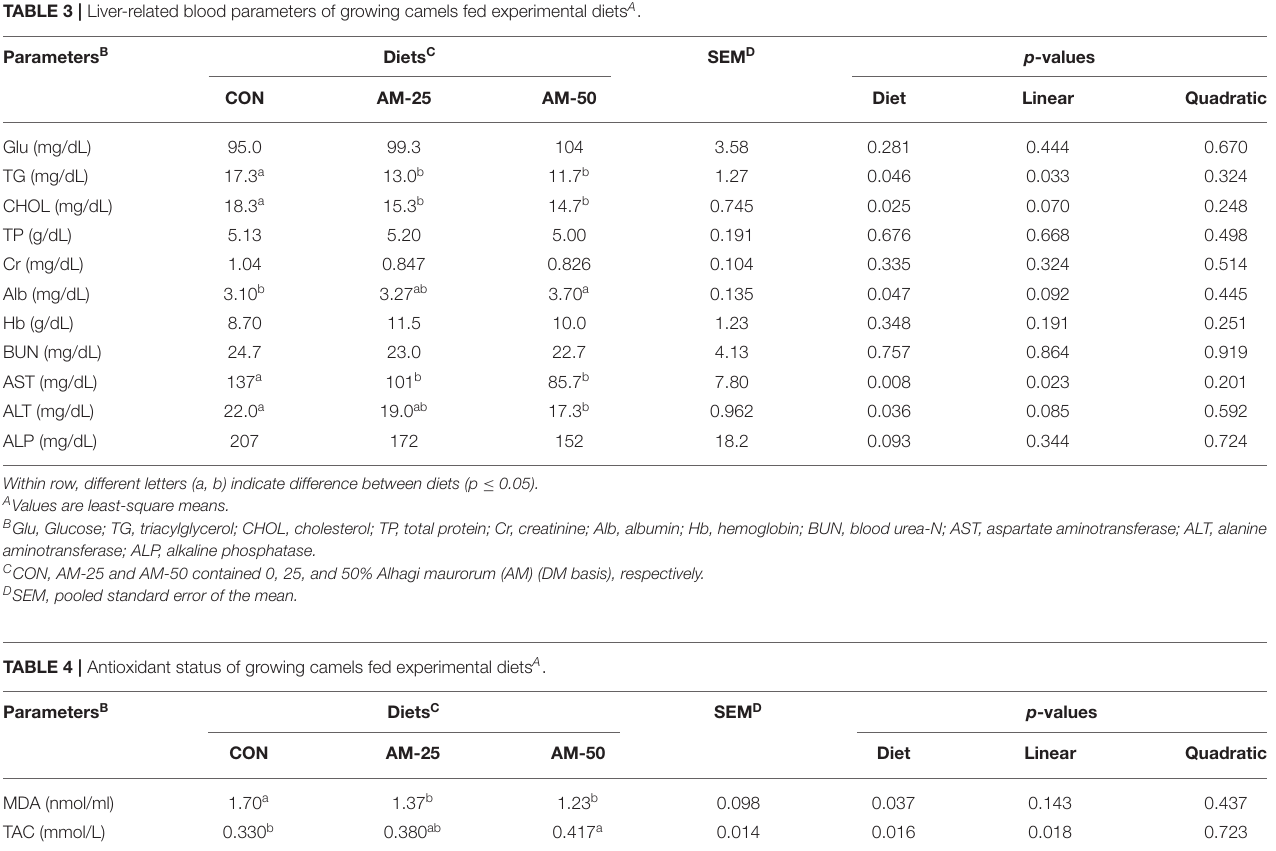
Diet Linear Quadratic